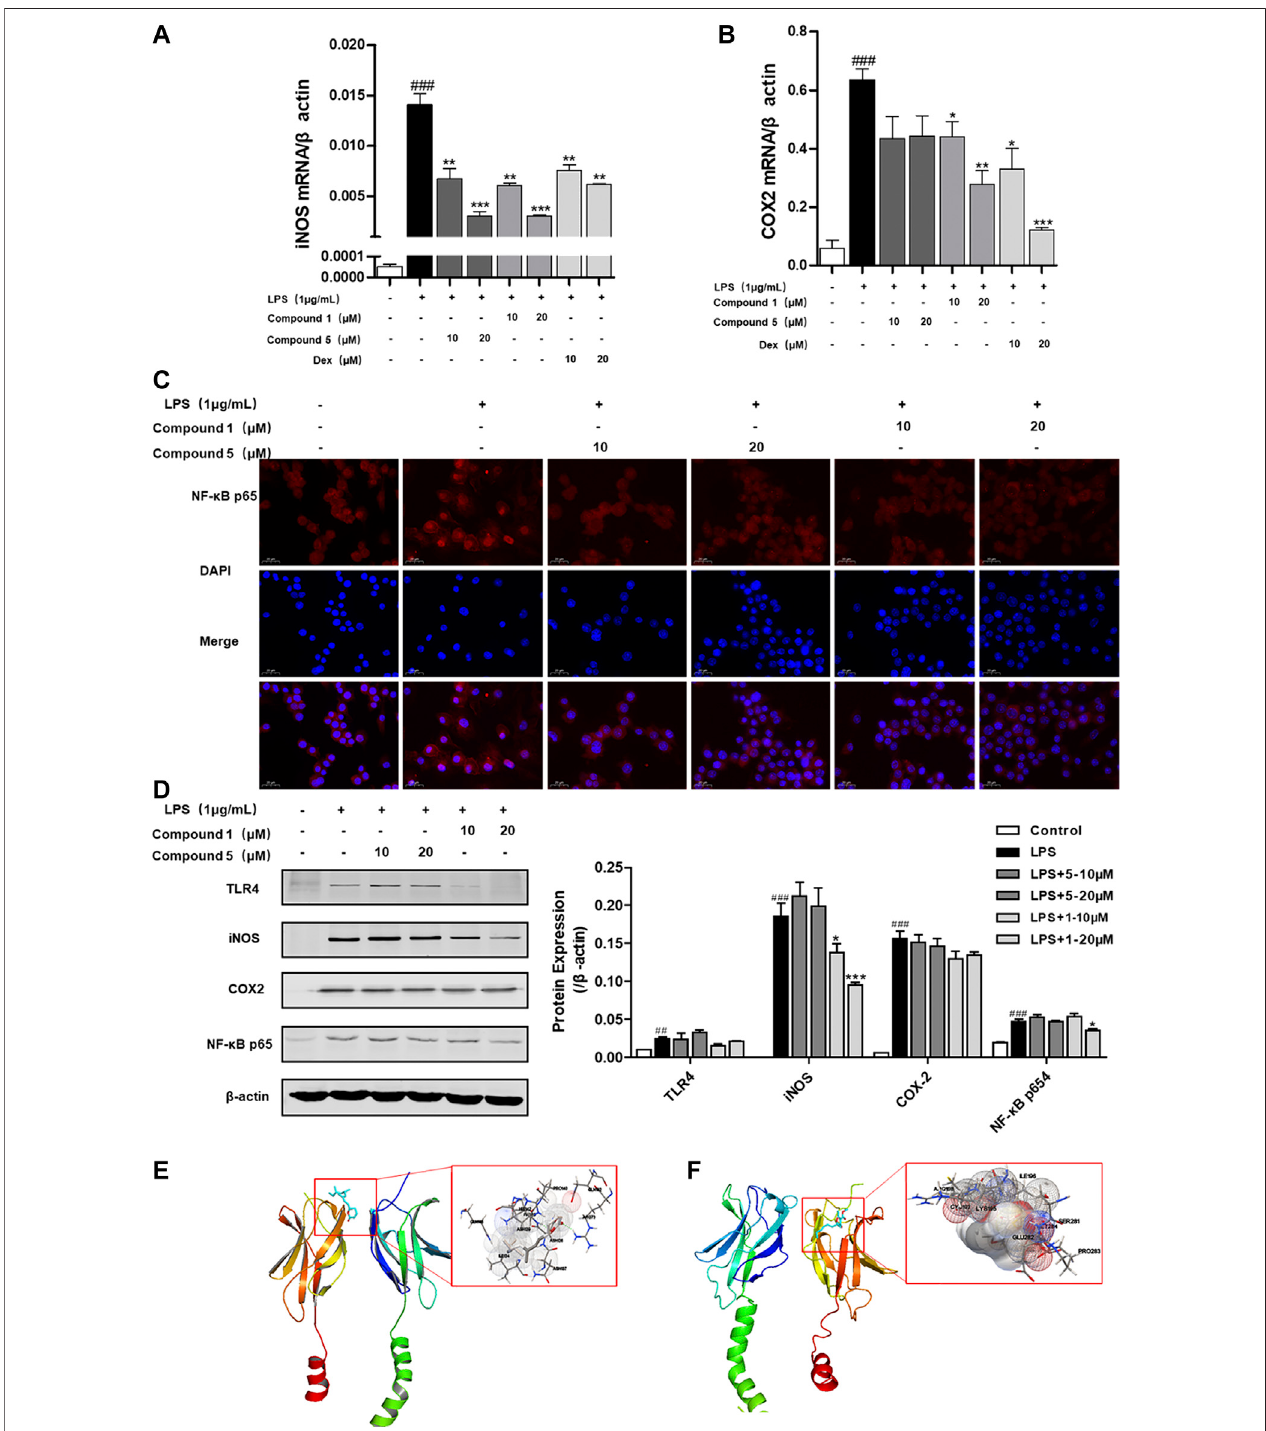
FIGURE 9 | 1 and 5 inhibit the nuclear translocation of NF- κ B p65 to exert anti-in fl ammation effect. Effects of 1 and 5 on the transcription level of in fl ammatory factorsiNOS (A) andCOX-2 (B) inLPS-inducedRAW264.7cells.Dexamethasone(Dex)wasusedasapositivecontrol.Datawerepresentedasthemean ± SEM( n (cid:2) 3). ### p < 0.001 vs. control, * p < 0.05, ** p < 0.01, *** p < 0.001 vs. model. (C) Effects of 1 and 5 on the expression of NF- κ B p65 in LPS-treated RAW264.7 cells by immuno fl uorescence(scalebar (cid:2) 20 μ m). (D) ProteinexpressionofTLR4,iNOS,COX-2,andNF- κ Bp65inRAW264.7cellsstimulatedwithLPS. ## p < 0.01, ### p < 0.001 vs. control, * p < 0.05, ** p < 0.01, *** p < 0.001 vs. model. In silico analysis of the interactions between NF- κ B p65 and 1 (E) and 5 (F) , respectively.